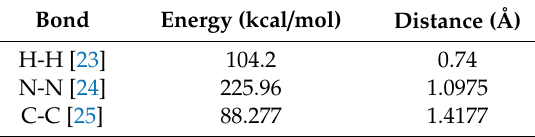
Table 2. Interatomic interaction